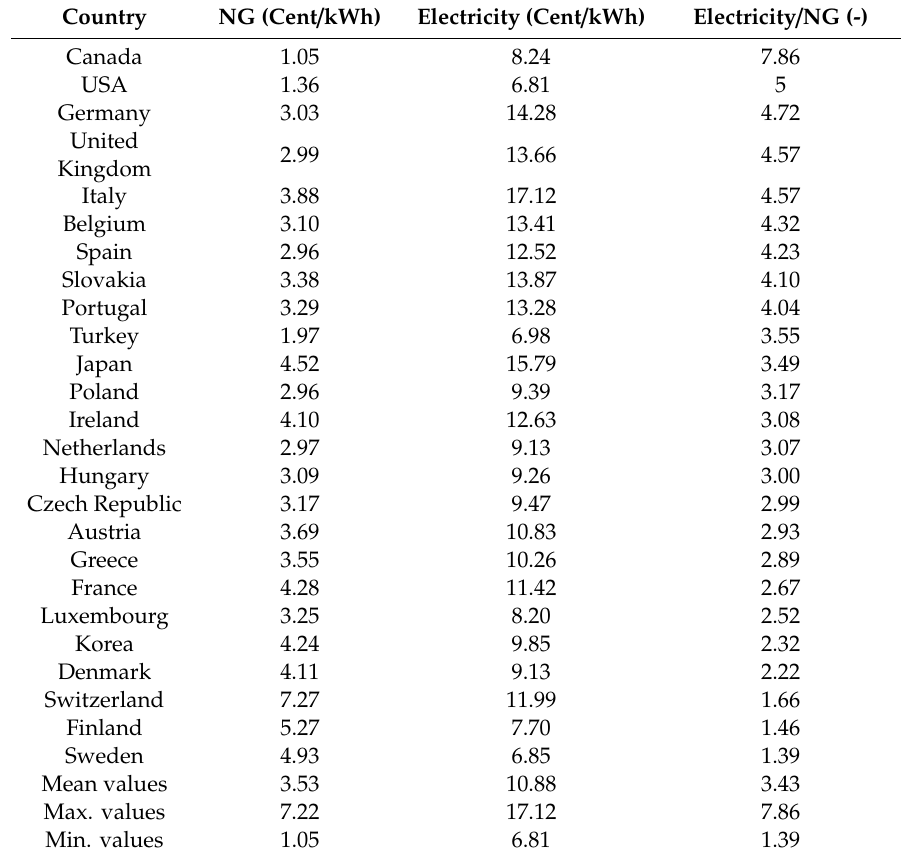
Table 1. Comparison of energy prices of industrial NG and electricity with di ff erent countries in 2018